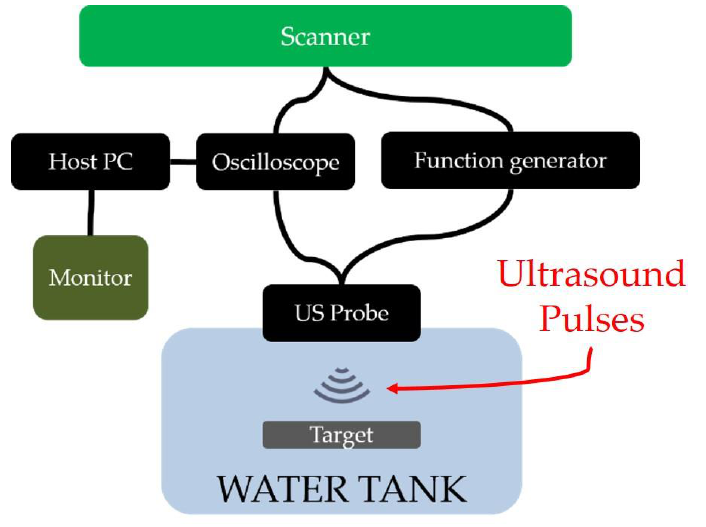
Figure 7. Measurement chain devoted to the pulse echo of the US probe.